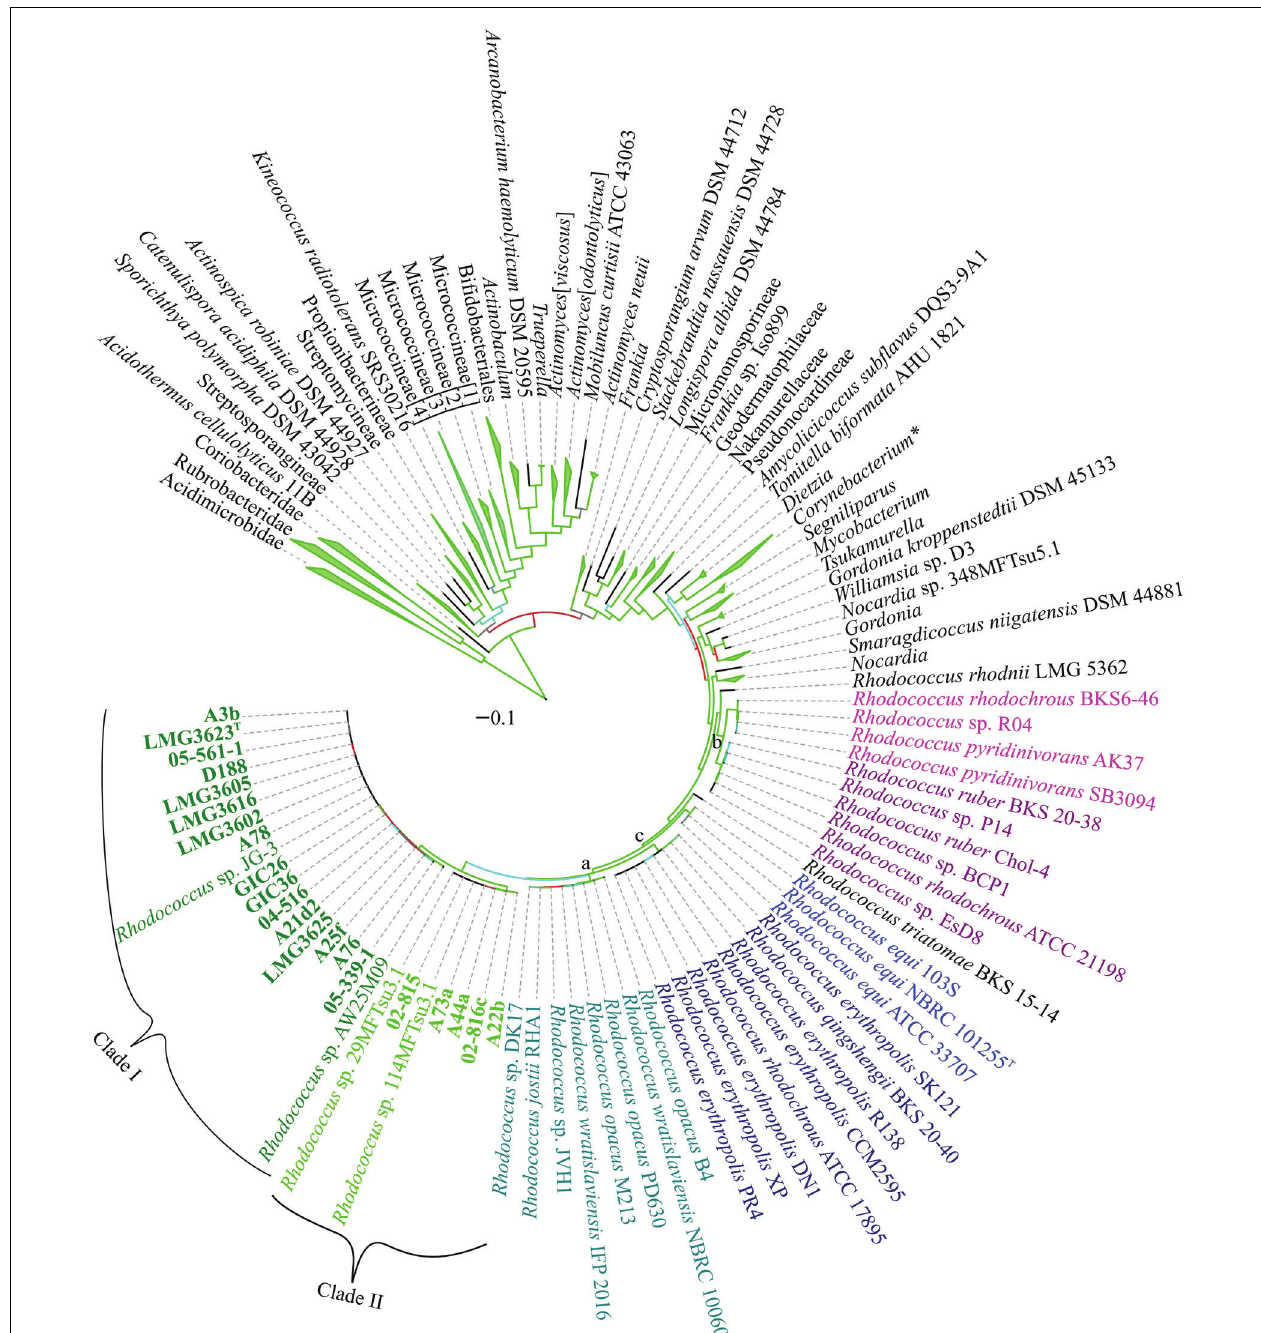
FIGURE 4 | Multi-locus sequence analysis maximum likelihood tree of the Actinobacterium phylum. Translated sequences for ftsY , infB , rpoB , rsmA , secY , tsaD , and ychF from 1316 members were identified using TBLASTN, aligned, and used to generate a multi-locus maximum likelihood tree. A total of 961 sequences were used as input for tree generation. The 21 Rhodococcus isolates sequenced by our group are shown in bold and the two clades that include phytopathogenic Rhodococcus spp. are indicated. The R. erythropolis , R. rhodochrous , and R. equi clades, previously identified based on a 16S rDNA phylogeny of Rhodococcus